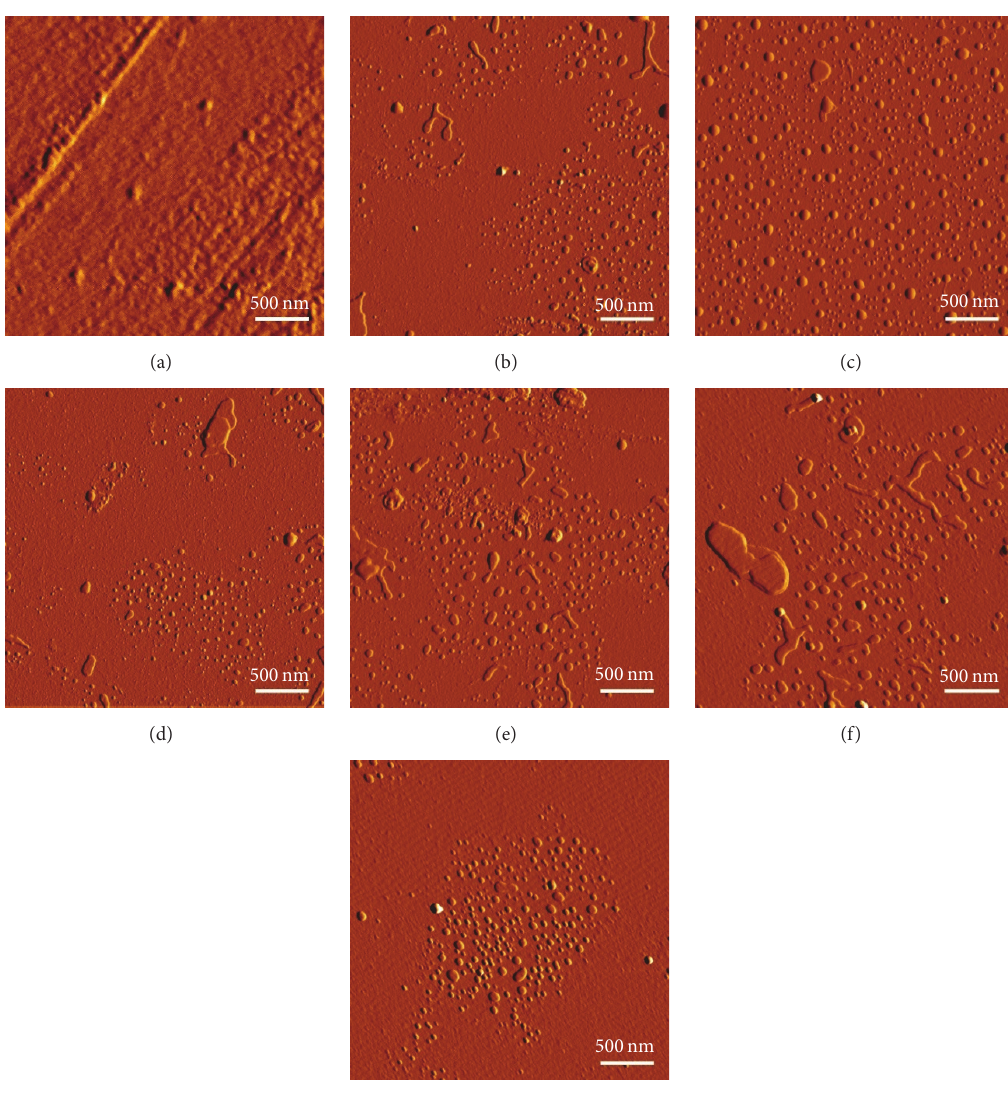
Figure 8: Visualisation of size and morphology of liposomes by atomic force microscopy. (a) 25kDa bPEI, (b) DOTAP, (c) hGDNT/DOTAP (5: 95), (d) PLFE/DOTAP (5 :95), (e) hGDNT/CH/DOTAP (5: 45 :50), (f) PLFE/CH/DOTAP (5:45 : 50), and (g) hGDNT/PC/CH/DOTAP (5: 30 : 35 :